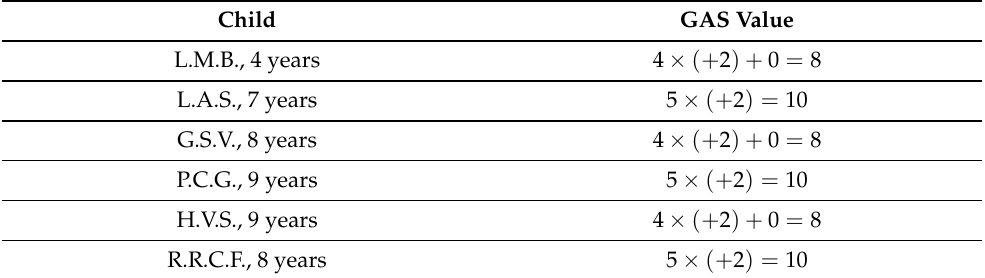
Table 3. Values of the GAS method for each of the children (the average value of all the children is